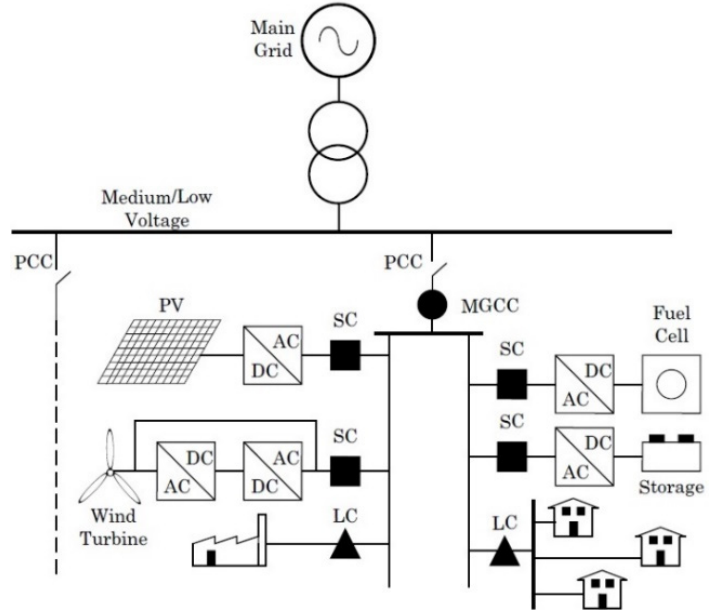
Figure 2. Basic structure of a microgrid (MG), including a centralized management system.